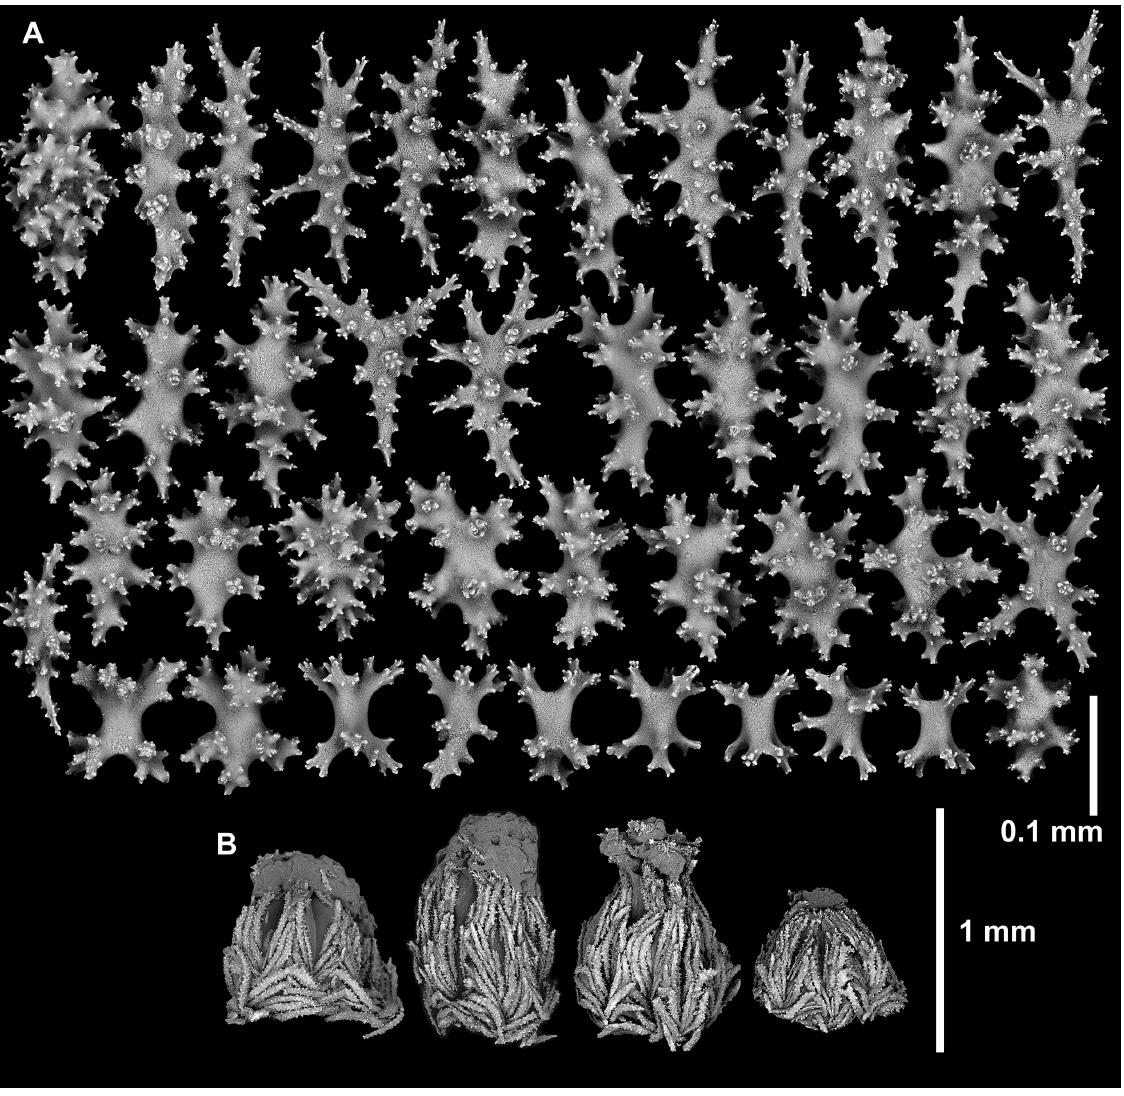
Fig. 21. Kotatea lobata gen. et sp. nov., holotype (NIWA 101313), SEMs of sclerites. A . Base interior. B . Polyps (in